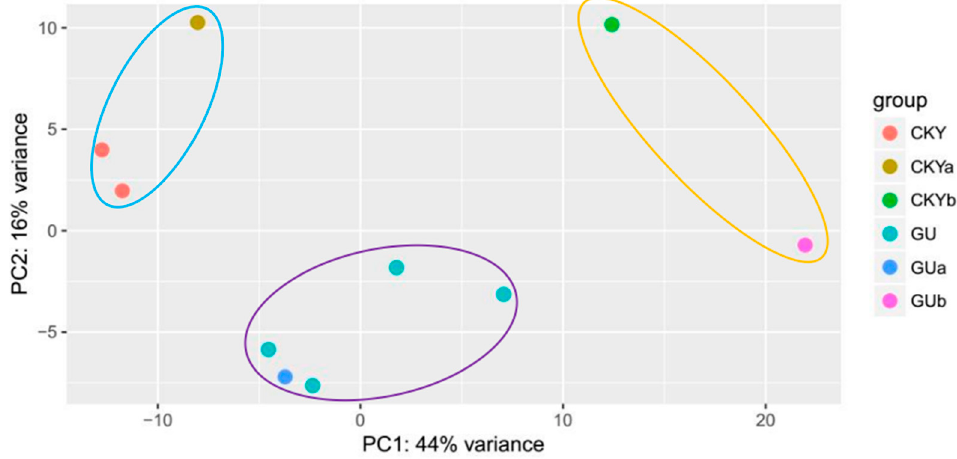
Figure 1. PCA of horse testicular tissues. CKYa represents CKY2a; CKY represents CKY1 and CKY3; GU represents GU1, GU2, GU3, and GU5; GUa represents GU4a; CKY2b represents CKY2b; and GUb represents GU4b.